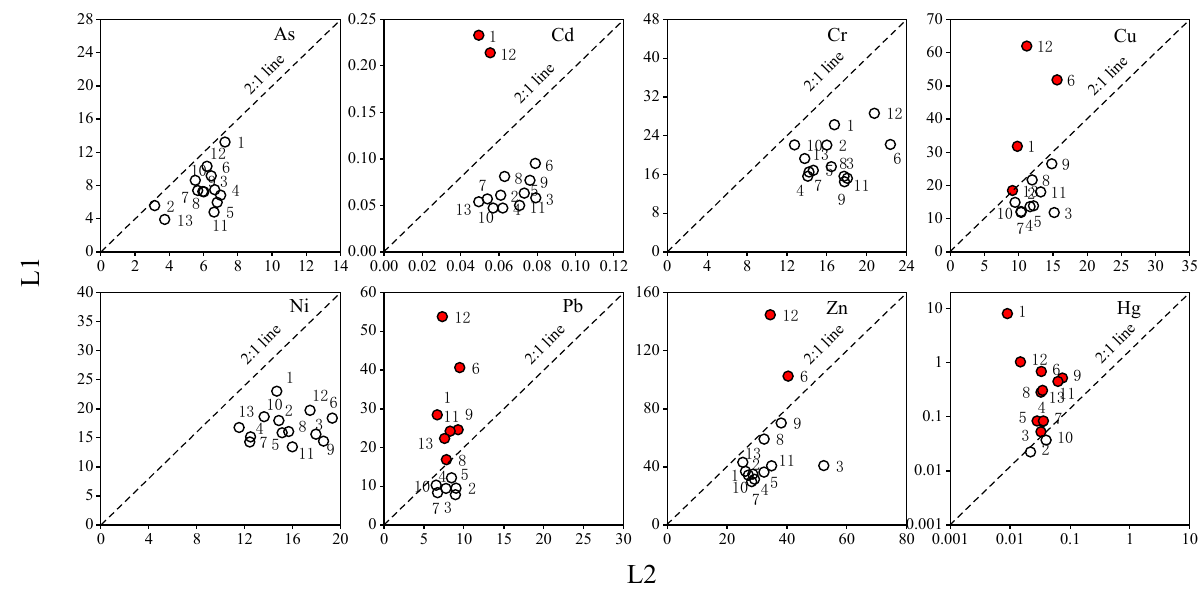
Figure 4. Concentrations of HMs in topsoil vs. subsoil.